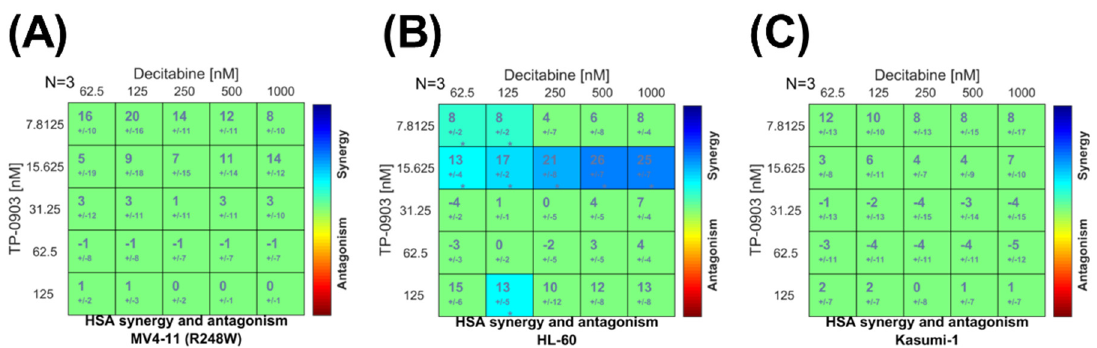
Figure 4. Combinatorial in vitro activity of TP-0903 and decitabine. MTT cell viability assays were performed by treating ( A ) MV4-11 (R248W), ( B ) HL-60, and ( C ) Kasumi-1 cell lines with varying concentrations of TP-0903 and decitabine for 72 h (n = 18 across three independent experiments). Data were analyzed with surface-response using the highest single agent (HSA) model using Combenefit software.